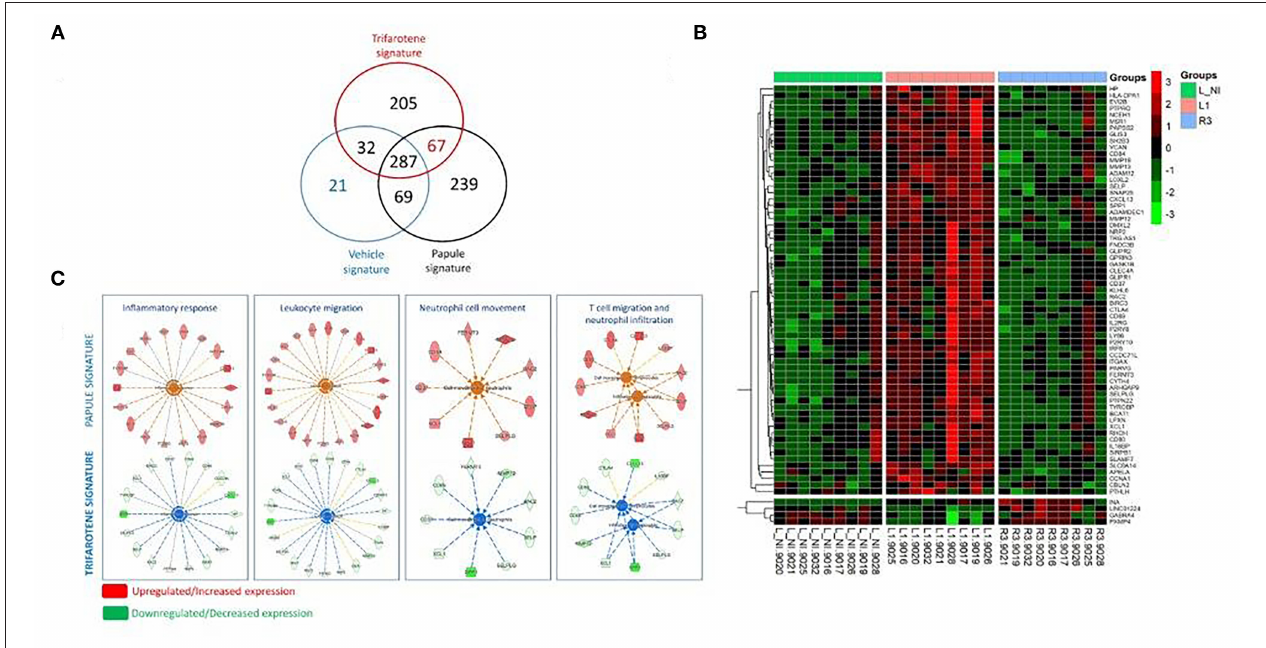
FIGURE 2 | Comparison of gene expression in acne papules, spontaneously resolved papules, and trifarotene treated papules. (A) Venn diagram highlighting the number of candidate differentially expressed genes. Vehicle signature : biopsy of a papule treated with vehicle vs. papule at baseline; papule signature : biopsy of a papule at baseline compared to non-involved skin; trifarotene signature : biopsy of a papule after trifarotene treatment vs. papule at baseline. (B) Heatmap highlighting gene expression changes between non-involved skin, papule at baseline, and papule after trifarotene treatment, for the 67 genes specifically regulated by trifarotene. Genes were clustered using average linkage and correlation distance. Gene expression levels were scaled by gene (green = lower gene expression, red = higher gene expression). No clustering of the sample was performed. Color bars at the top displays the clinical group of each sample: L-NI, non-involved skin; L1, papule at baseline; R3, papule after treatment with trifarotene; (C) IPA of the 67 genes revealed upregulation of pathways associated with inflammatory response, leukocyte migration, neutrophil movement, and T cell migration in the papule signature that are concomitantly downregulated following trifarotene